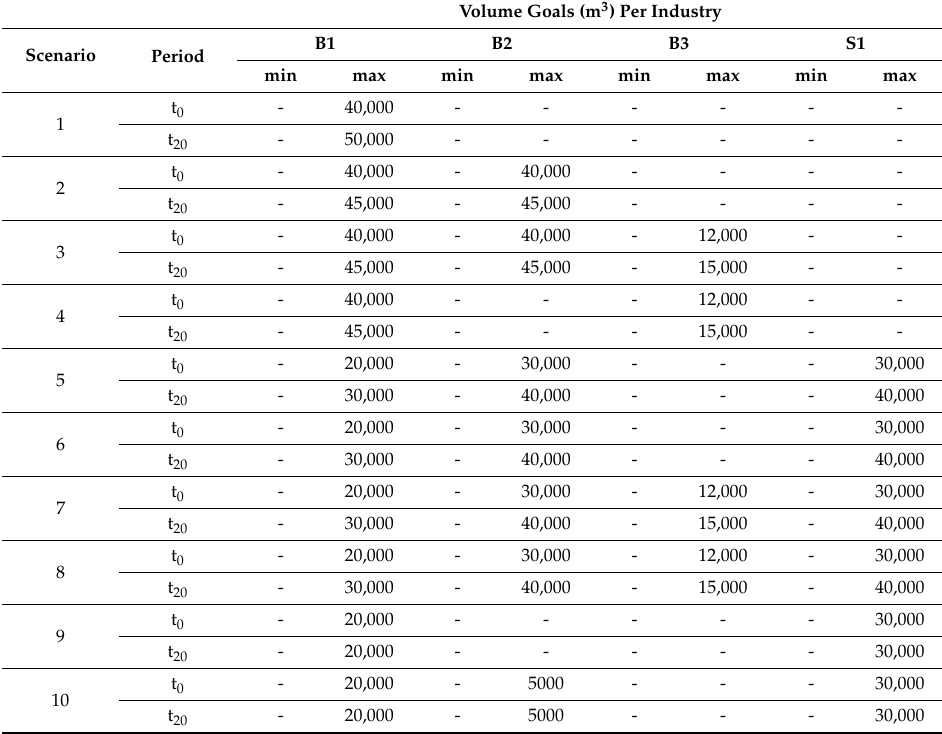
Table A4. Initialization maximum volume goals per scenario and industry for used in the first simulation (FSD0).